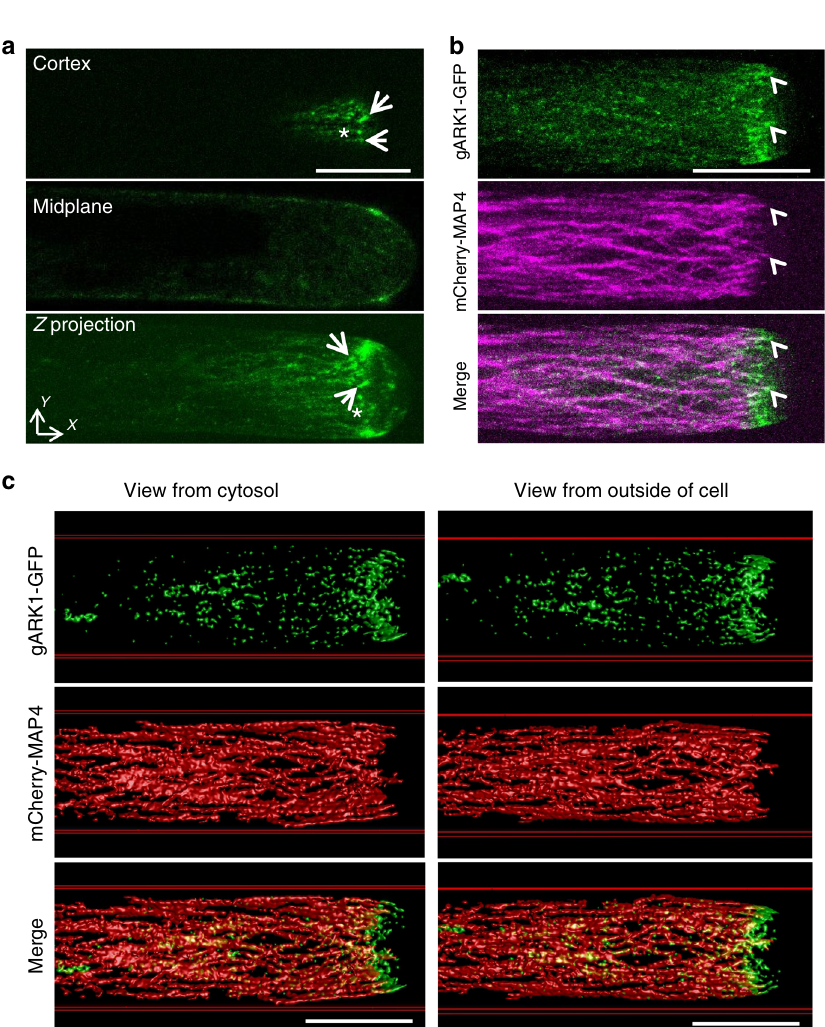
Fig. 5 ARK1 localizes to growing ends of microtubules in the cortex of the subapical region of growing root hairs. a Localization of gARK1 – GFP in growing root hairs. Distribution of gARK1 – GFP in the cortex, midplane, and Z-projection of a growing root hair. Arrows indicate gARK1 – GFP comets; asterisks indicate gARK1 – GFP punctae. gARK1 – GFP was introduced into ren9-1 and imaged in growing root hairs of 5-d seedlings. b Distribution of gARK1 – GFP and MTs labeled by mCherry-MAP4 in a growing root hair. Arrowheads indicate the MT plus-end localization of gARK1 – GFP. Both experiments were independently repeated six times. c Spatial relation of gARK1-RFP (top and merged panels) and mCherry-MAP4 (middle and merged panels) in a 3D model. The left image is a view from the cytosol; the right is a view from the outside of the cell. Scale bars indicate 10 µ